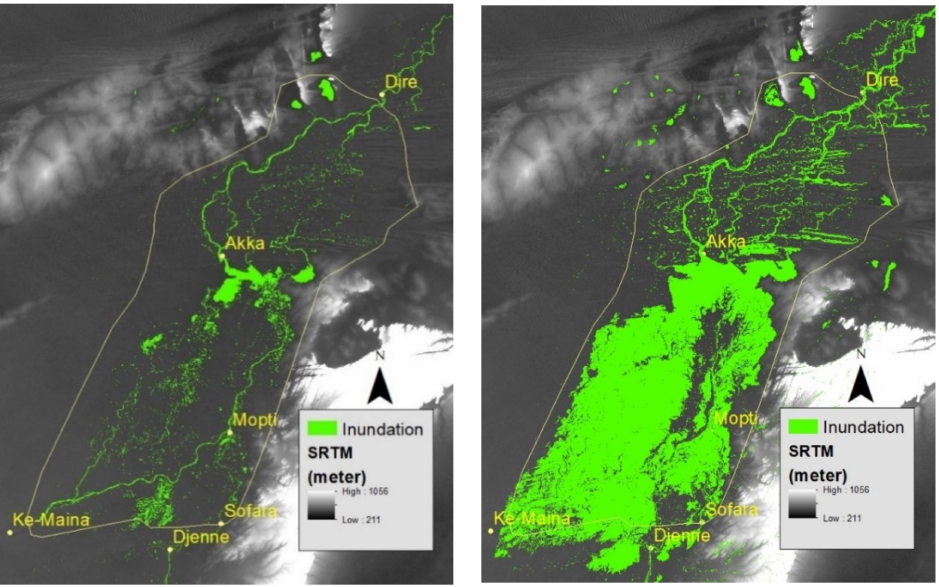
Figure 4. Satellite Images of inundation extents of the Delta on 28 July 2001 ( left ) and 16 October 2001 ( right ) (Source: Zwarts, et al.,